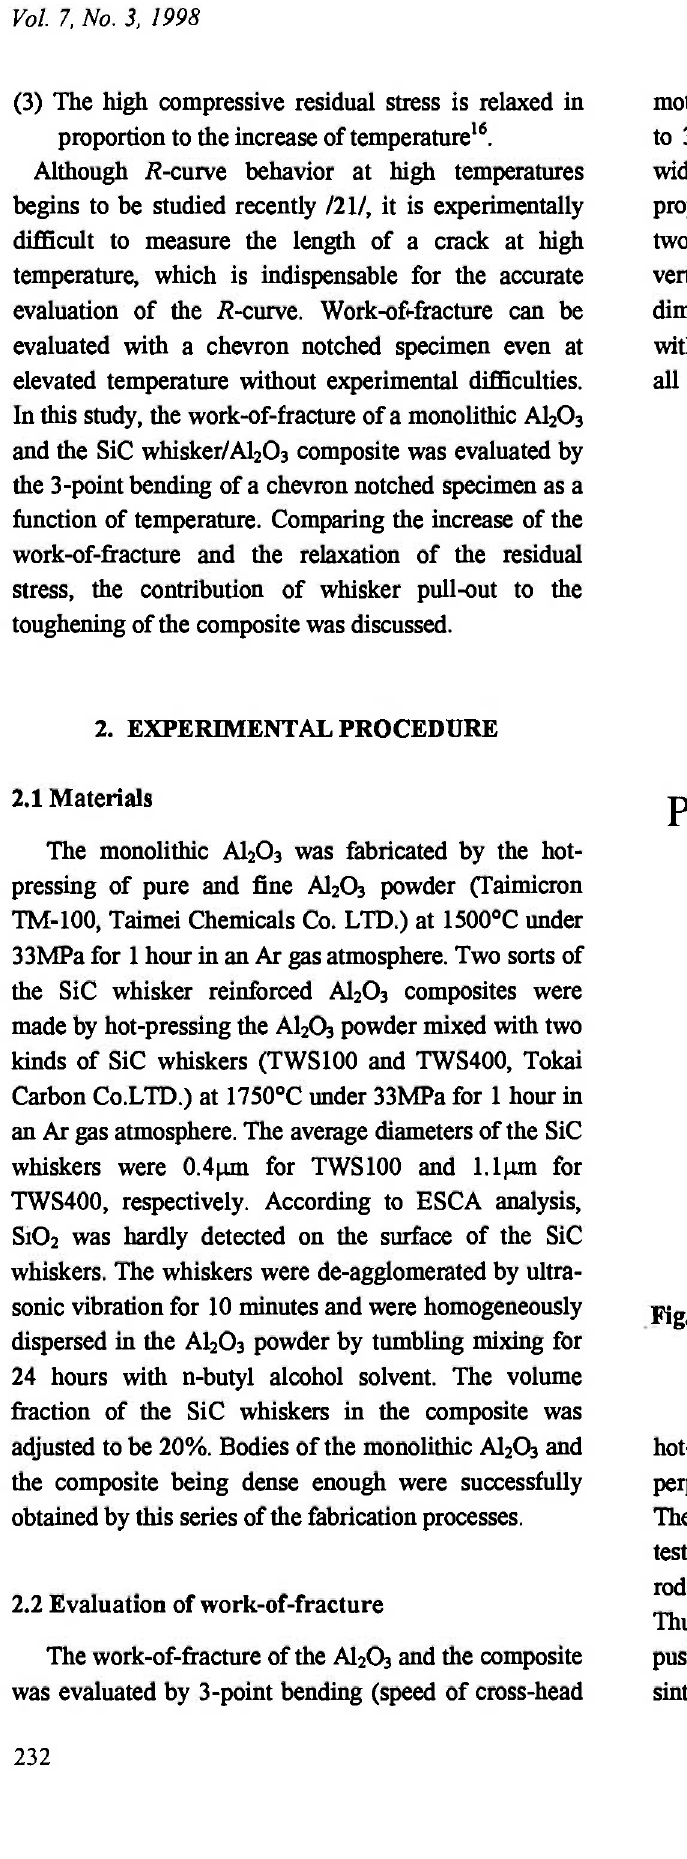
Fig. 1: Schematic illustrations of 3-point bending with a chevron notched